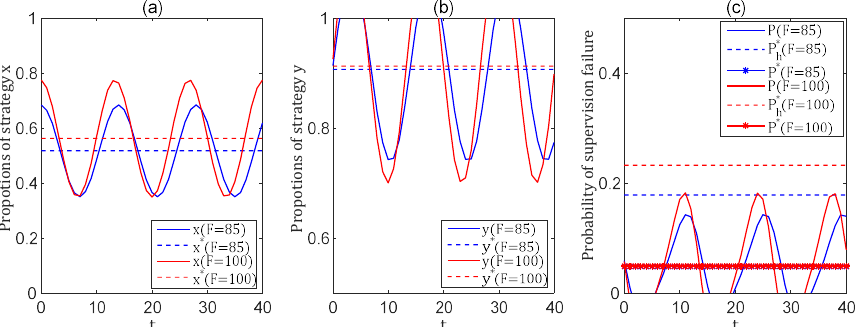
Figure 7. The influence of punishment F on the periodical fluctuation. ( a ) The periodical fluctuation in proportions of strategies x with different punishments F = 85 and F = 100. ( b ) The periodical fluctuation in proportions of strategies y with different punishments F = 85 and F = 100. ( c ) The periodical fluctuation in the probability of supervision failure P with different punishments F = 85 and F =